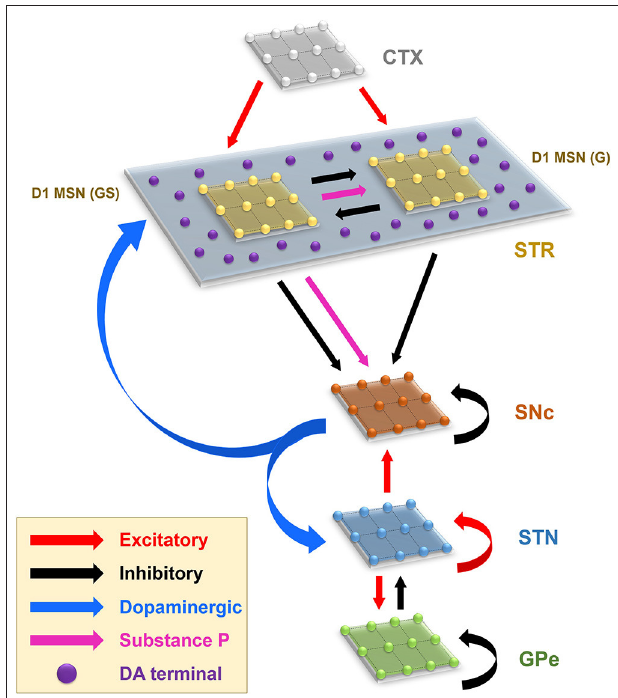
FIGURE 1 | Model architecture of the levodopa-induced toxicity. CTX, cortex; STR, striatum; D1 MSN (GS), D1-type medium spiny neuron (GABAergic and Substance P); D1 MSN (G), D1-type medium spiny neuron (GABAergic); SNc, substantia nigra pars compacta; STN, subthalamic nucleus; GPe, globus pallidus externa; DA,